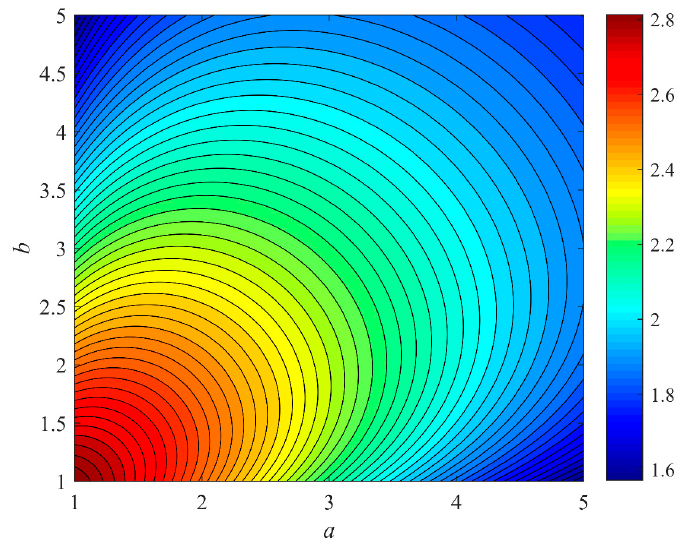
Figure 10. The shape entropies of ellipsoids with different axial length ratios of a and b , provided that c = 1. The blue area suggests a more irregular shape. The lower left corner corresponds to the sphere.